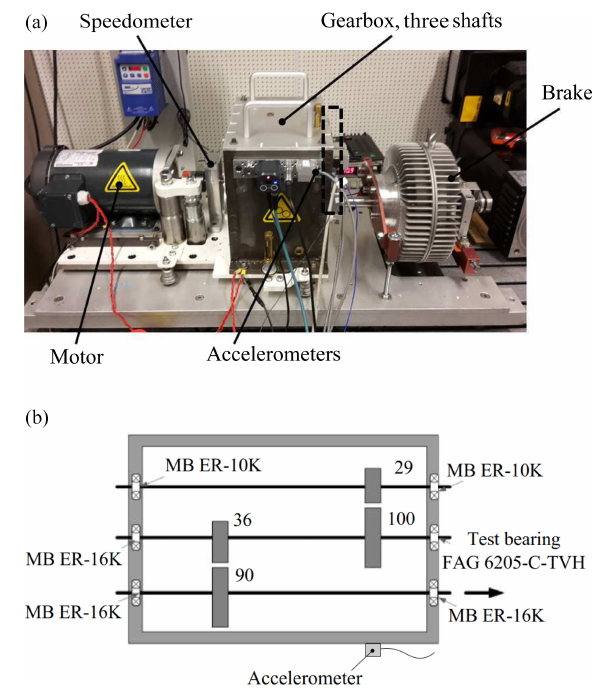
Figure 4. Gearbox setup comprising a motor, three-shaft gearbox and brake to introduce a load.